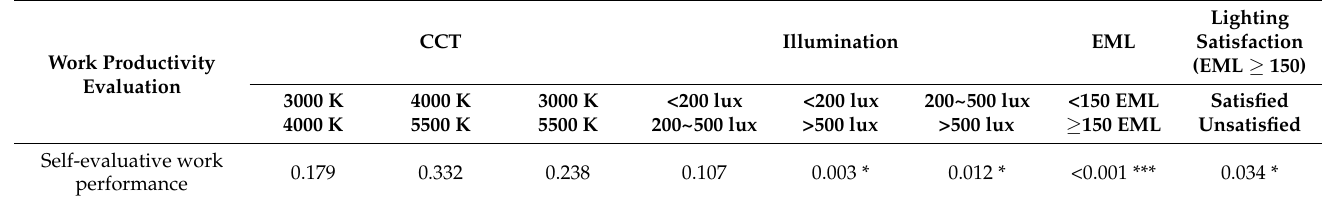
Table 3. Significant ( p ) results of T -test for work productivity evaluation in